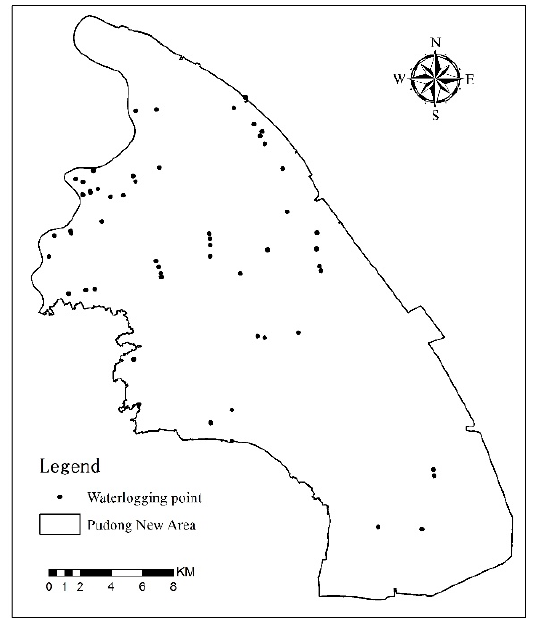
Figure 3. Distribution of the waterlogging points in the Pudong New Area.